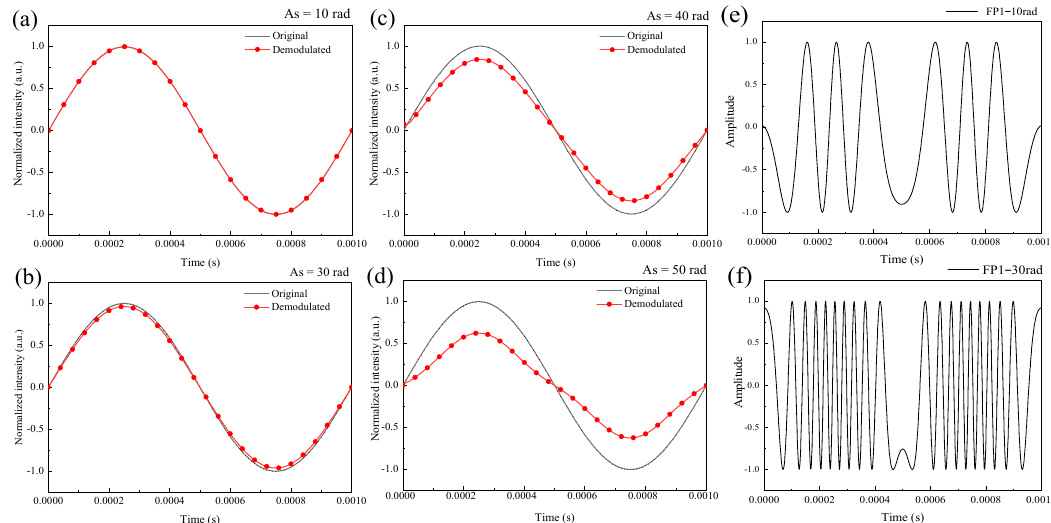
Figure 2. Simulation of demodulated signals with sound wave signal amplitudes of 10 rad ( a ), 30 rad ( b ), 40 rad ( c ), 50 rad ( d ) and the output signal of the FP1 cavity at signal amplitudes of 10 rad ( e ), 30 rad ( f ).